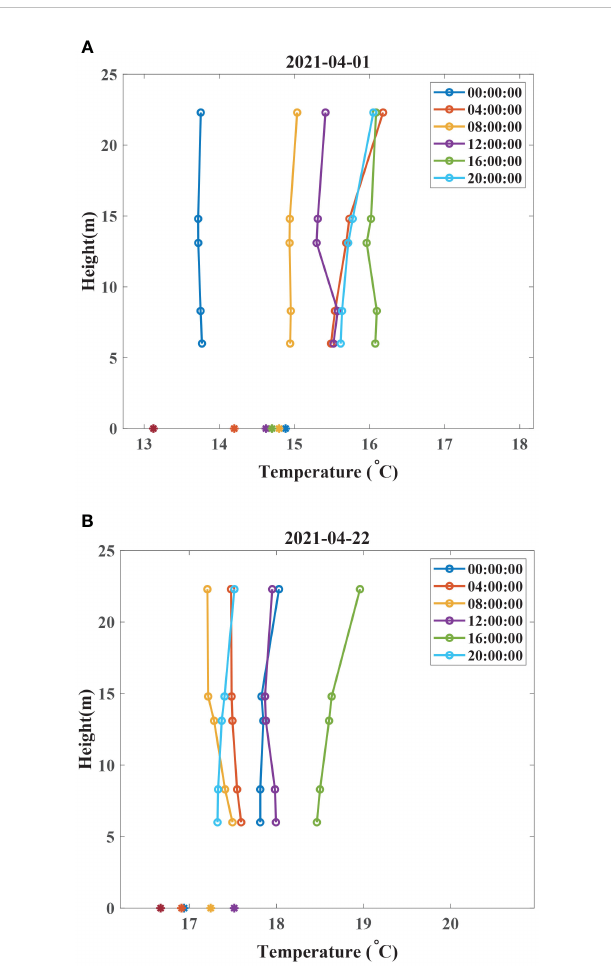
FIGURE 6 Change trends of the AT pro fi le on different days and at different times of the day. (A) 01 April 2021; (B) 22 April